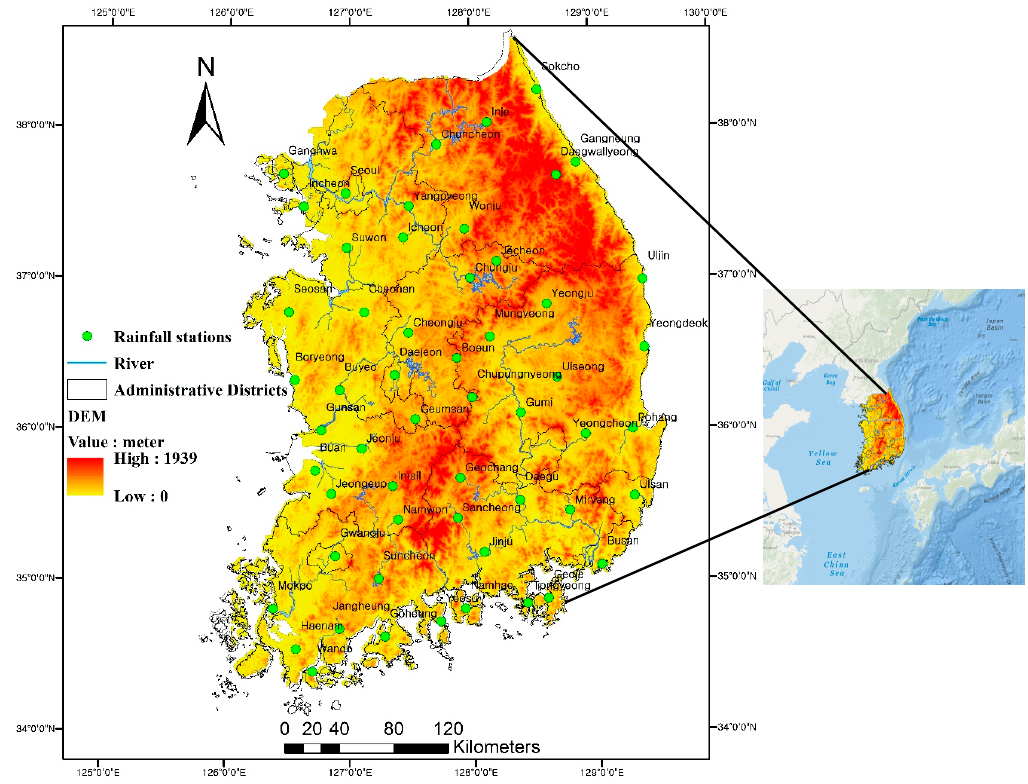
Figure 1. Location of study area and rainfall stations.